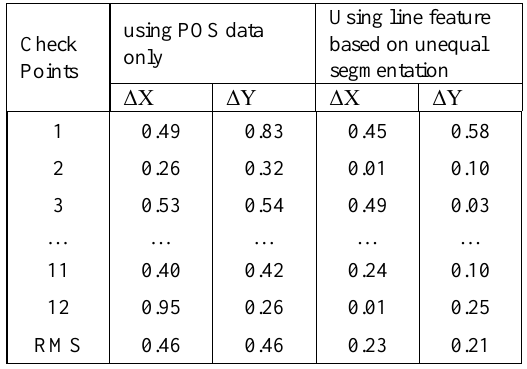
Table 1. Absolute precision evaluation by check points(Unit: m)